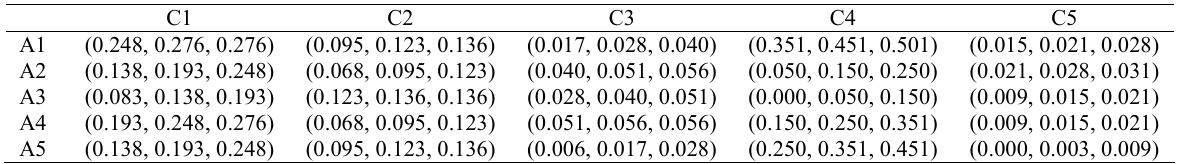
Table 4. Fuzzy weighted decision